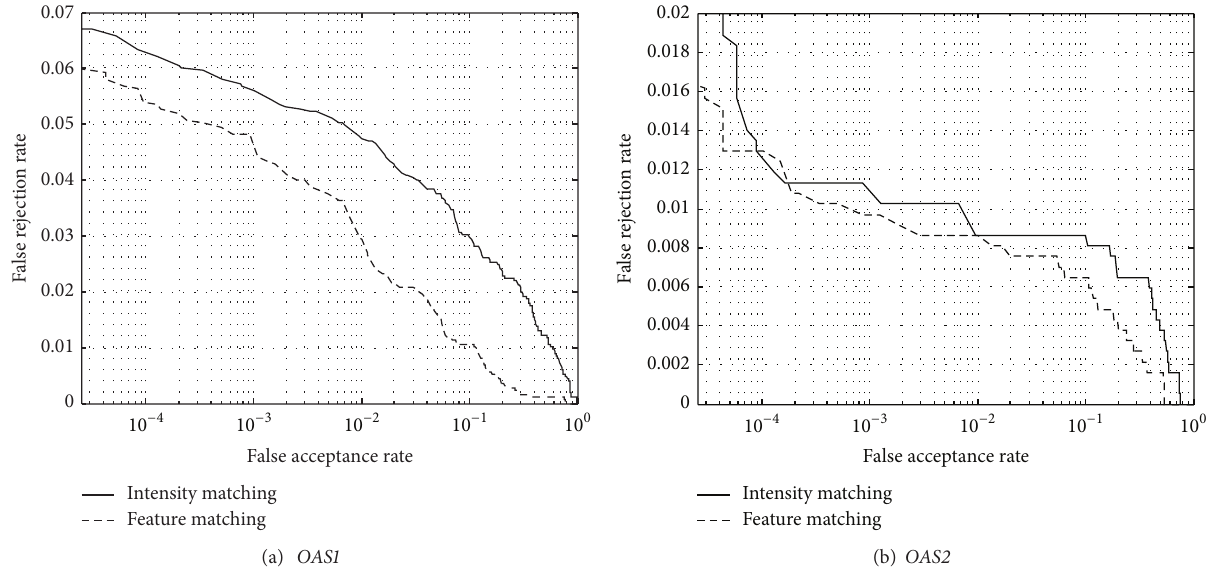
Figure 6: The ROCs of pixel-based (intensity) matching and the proposed feature-based